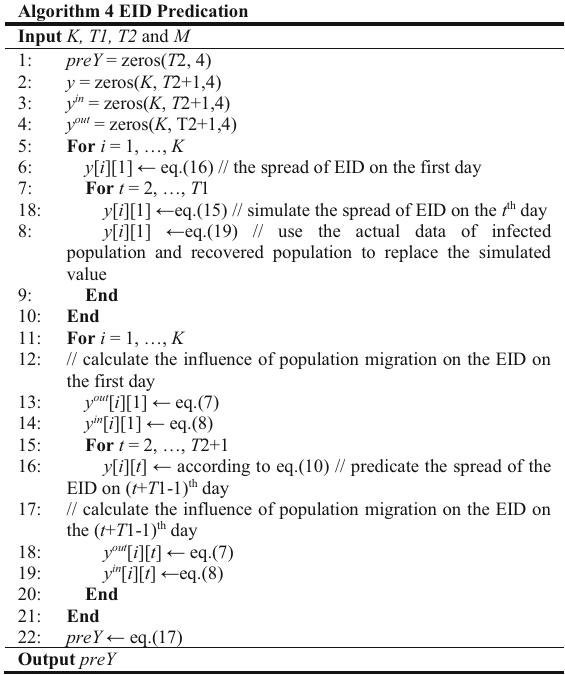
migration for T 1 days are filled into M . Finally, according to Eq. (23), we can predicate the population migration in the next T 2